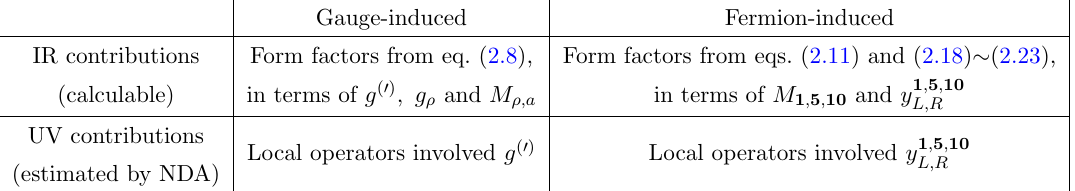
Table 1 . The sources of the scalar potential in the